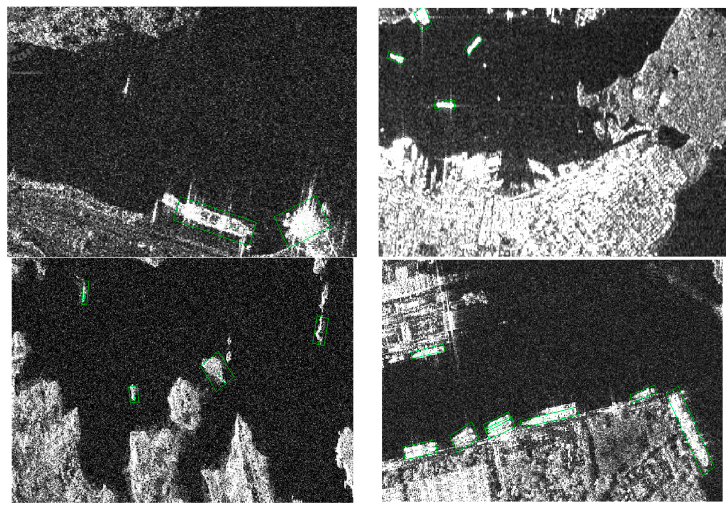
Figure 8. Some false alarms and missed ships in the SSDD. From the above images, we can see that the strong scatter and isolated island are easily detected as ships. Some ships near shore are easily neglected. Top-left shows a target in the bottom-right is wrongly detected; top-right shows a target in the top-left is wrongly detected; bottom-left shows two targets in the left are wrongly detected; bottom-right shows the ship is missed in the